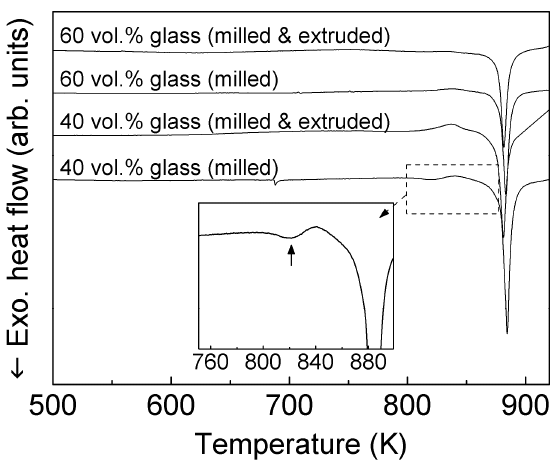
Figure 9. DSC scans (30 K/min) of the glass-brass composite powders milled for 20 h (milled) and of the corresponding bulk composites consolidated by hot extrusion (milled and